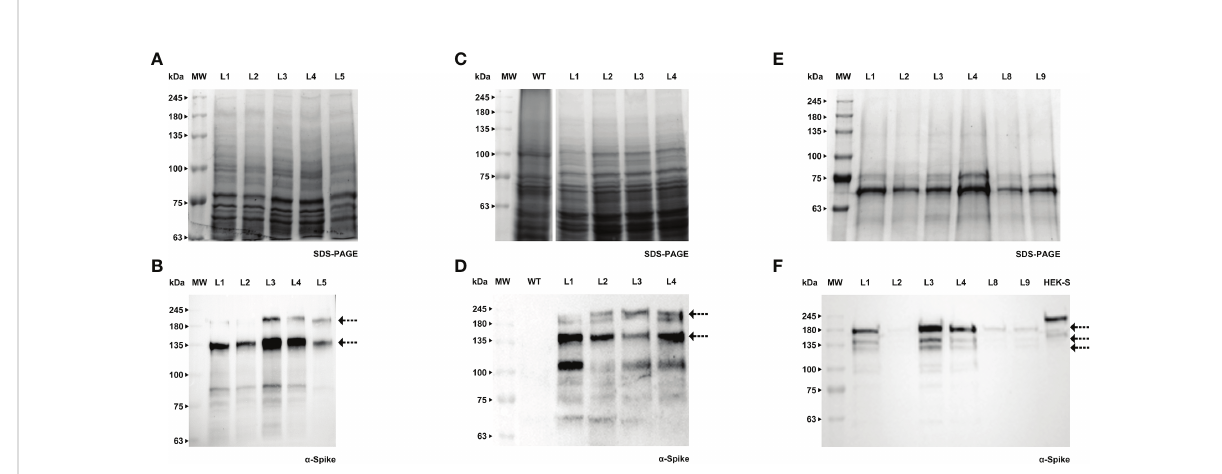
FIGURE 5 Detection of Spike recombinant protein in calli (A, B) , cell extracts (C, D) and spent medium (E, F) of BY-2. (A) Stained gel containing total protein extract of fi ve calli of BY-2. (B) Corresponding WB with anti-Spike antibody. (C) Stained gel containing cellular extract of four independent BY-2 cell lines, WT - wild type. (D) Corresponding WB with anti-Spike antibody. (E) Stained gel containing spent medium of six independent BY-2 cell lines. Samples were concentrated with a centrifugal fi lter (L1 - 23x, L2 - 14x, L3 - 19x, L4 - 39x, L8 – 17x, L9 – 13x). (F) Corresponding WB with anti-Spike